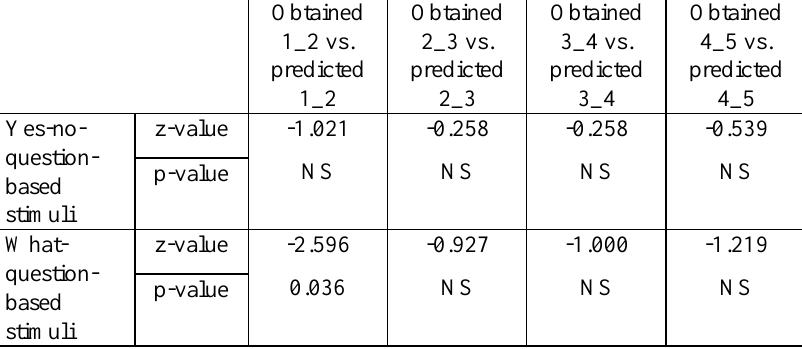
Table XI. z- and p-values of four Wilcoxon matched pairs signed rank tests for each continuum comparing the obtained and predicted discrimination rate for each pair of